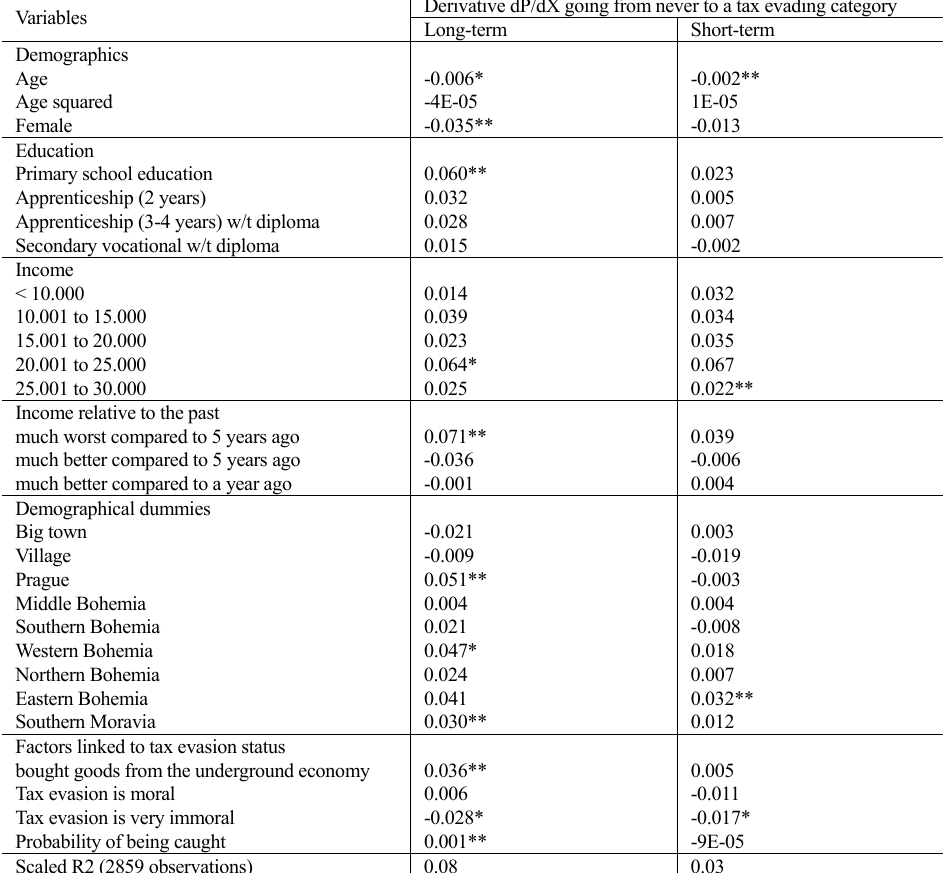
Table A.3 : Logit Regression Results for Pne (transition from never to a tax evasion stage) in the Czech Republic, Marginal Effects for Combined